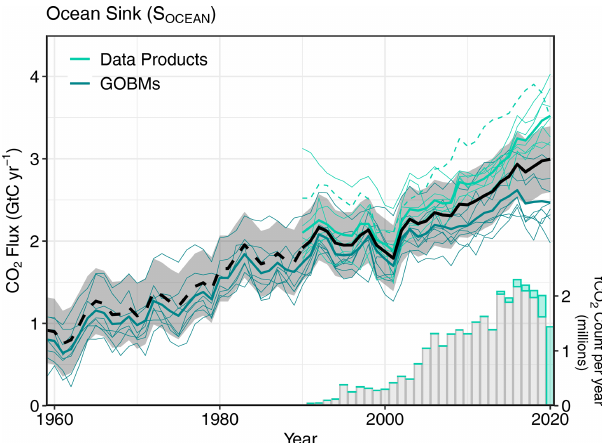
Figure 9. Comparison of the anthropogenic atmosphere–ocean CO 2 flux showing the budget values of S OCEAN (black; with the uncertainty in grey shading), individual ocean models (teal), and the ocean f CO 2 -based data products (cyan; with Watson et al. (2020) in dashed line as not used for ensemble mean). The f CO 2 -based data products were adjusted for the pre-industrial ocean source of CO 2 from river input to the ocean, by subtracting a source of 0.61GtCyr − 1 to make them comparable to S OCEAN (see Sect. 2.4). Bar-plot in the lower right illustrates the number of f CO 2 observa- tions in the SOCAT v2021 database (Bakker et al., 2021). Grey bars indicate the number of data points in SOCAT v2020, and coloured bars the newly added observations in